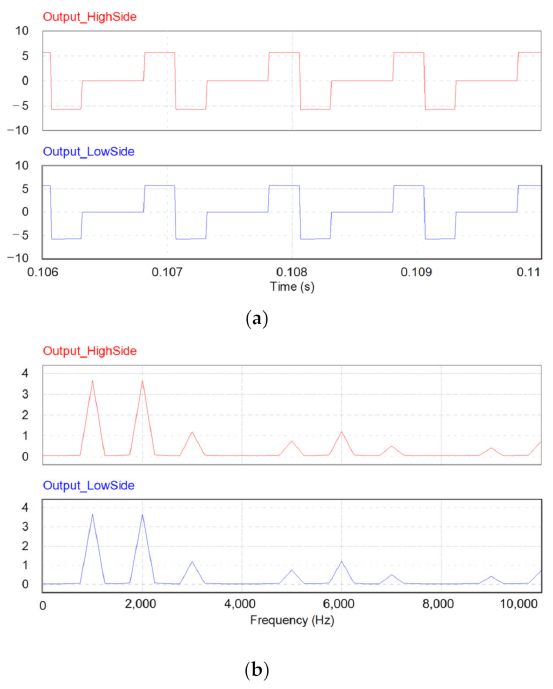
Figure 11. Frequency and FFT characteristics of Zone 2: ( a ) frequency characteristics of Zone 2